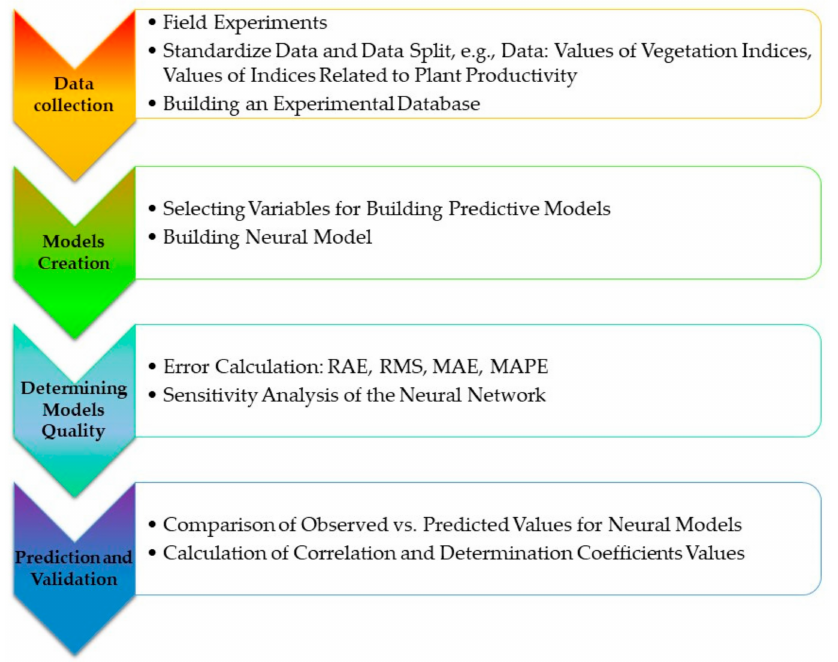
Figure 1. Flowchart showing the steps of working with predictive